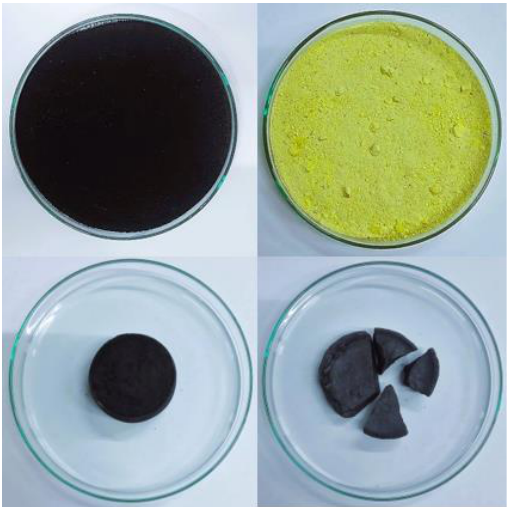
Figure 2. The biochar from applewood chips ( left , upper corner ); sulfur ( right , upper corner ); SBC ( bottom ) — samples located in the Petri ditches with the diameters of 15 cm.